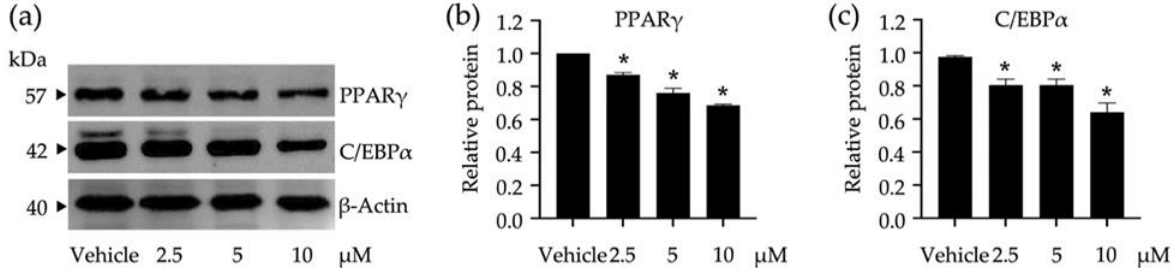
Figure 4. Impacts of compound 3 on the peroxisome proliferators activated receptor γ (PPAR γ ) and CCAAT/enhancer-binding protein α (C/EBP α ) expression in 3T3-L1 cells. The band intensities of these transcription factors were visualized by Western blotting assay ( a ) and used for calculating their expression relative to β -Actin as a reference protein ( b , c ). Non-cytotoxic concentrations (2.5, 5, and 10 µM) of compound 3 were used in this study. The graphical results demonstrate means ± SDs derived from three independent experiments. The asterisk (*) represents a statistical difference at p < 0.05 between the treatment and untreated vehicle control made of 0.5% ( v / v ) dimethyl sulfoxide, assessed by one- way ANOVA with Tukey’s post hoc test.